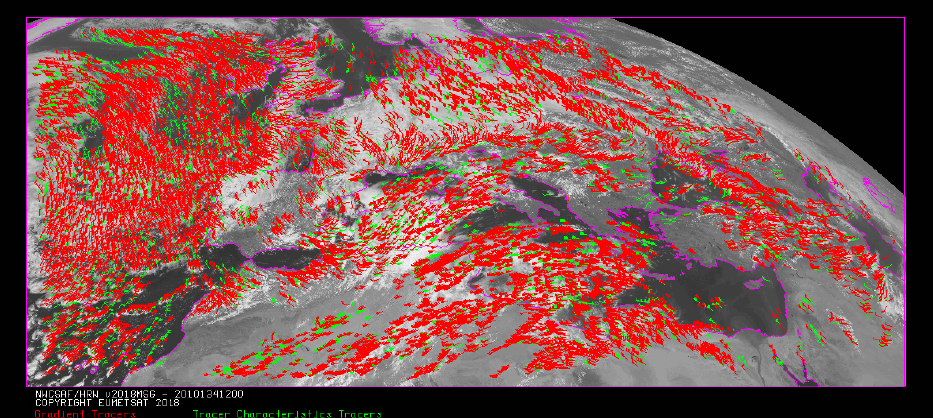
Remote Sens. 2019 , 11 , x FOR PEER REVIEW